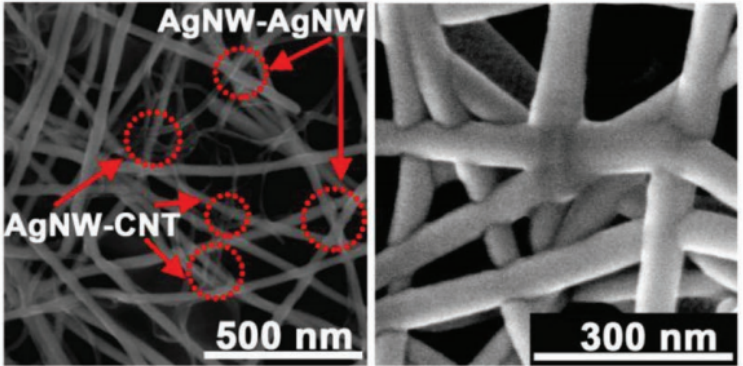
Figure 12. Typical SEM image of AgNW/CNT hybrids after cold welding ( left ) and SEM image of welded AgNW film ( right ). Reprinted with permission from [115]. Copyright 2019 John Wiley and